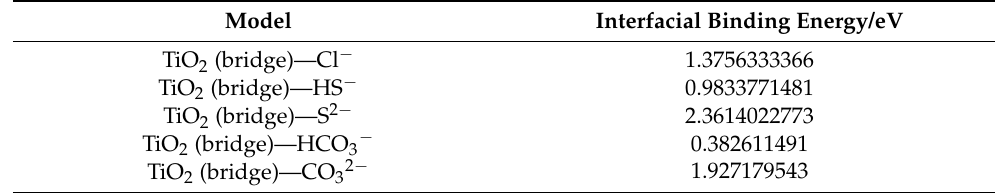
Table 5. Interface binding energy between corrosive species and the bridge position of the TiO 2 (110) crystal